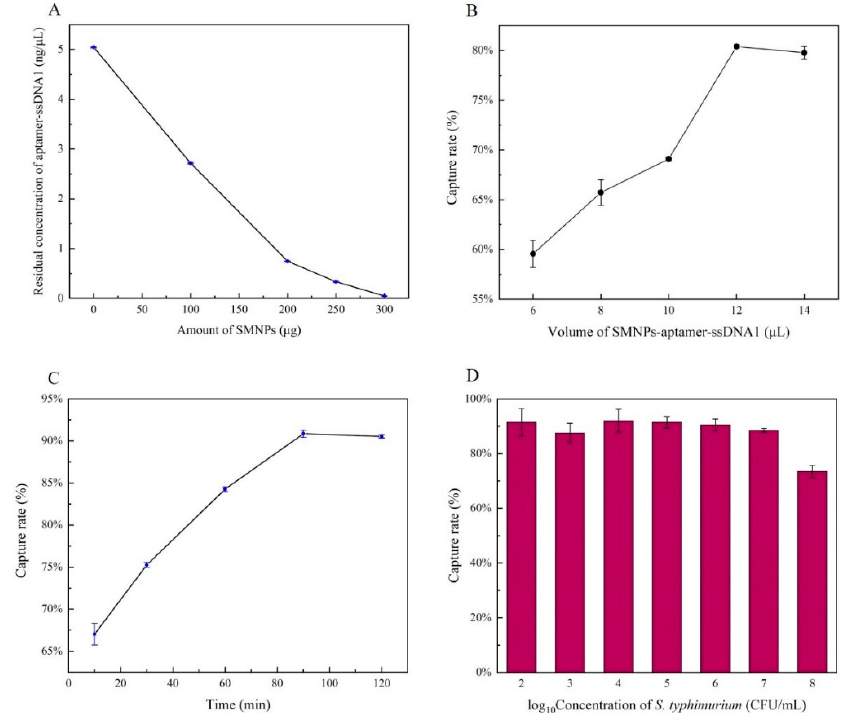
Figure 2. Optimization of capture rate for SMNPs–aptamer–ssDNA1 against Salmonella Typhimurium. Effect of the amount of SMNPs on residual aptamer–ssDNA1 concentration ( A ); effect of the volume of SMNPs–aptamer–ssDNA1 on capture rate ( B ); effect of the reaction time on capture rate ( C ); effect of the concentration of S. Typhimurium on capture rate ( D ); data represent mean ± SD ( n = 3). Error bars indicate the standard errors of three independent experiments.